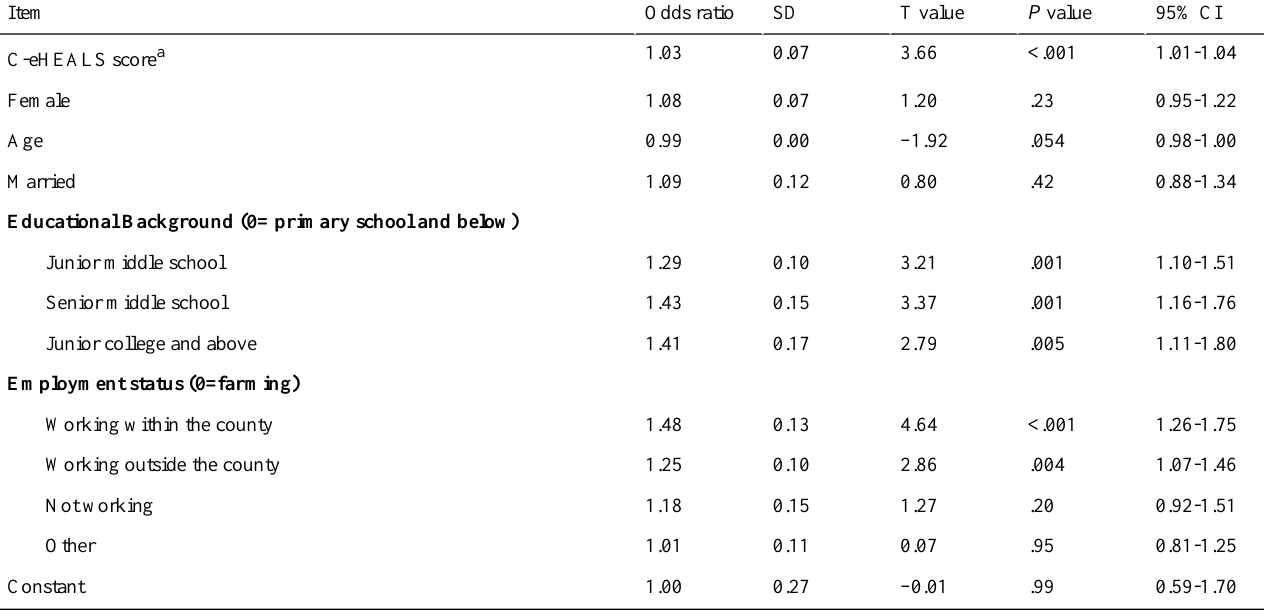
Table 5. Poisson regression results of relationship between C-eHEALS score and SOHISB.